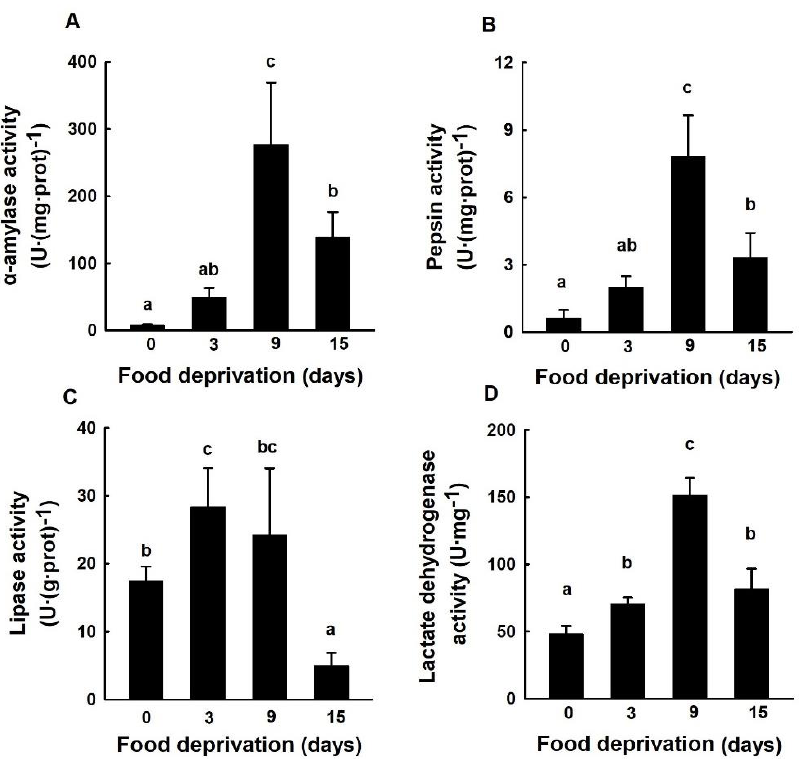
Figure 7. The activities of the digestive enzymes ( A ) α -amylase, ( B ) pepsin, and ( C ) lipase and the activity of the metabolic enzyme ( D ) lactate dehydrogenase of E. sinensis under different degrees of food deprivation. Different lowercase letters indicate significant differences among treatments ( p ≤ 0.05).